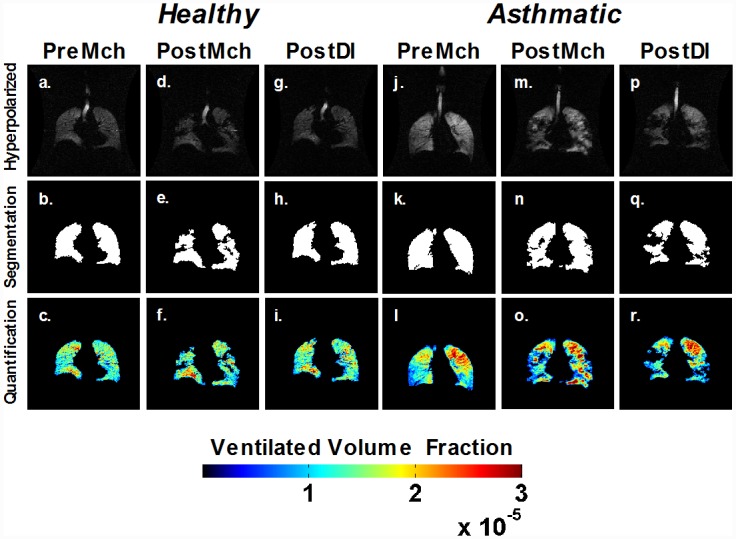
Single slice ventilation images for a healthy and asthmatic subject for PreMch, PostMch, and PostDI.HP 3He-MRI images (top row) are first segmented to evaluate for ventilated regions (middle row) and quantified to determine a mapped-out VVF (bottom row). Note the increased pockets of elevated ventilation in both healthy and asthmatics following a Mch-challenge and the lack of recovery for the asthmatic after a series of DIs.